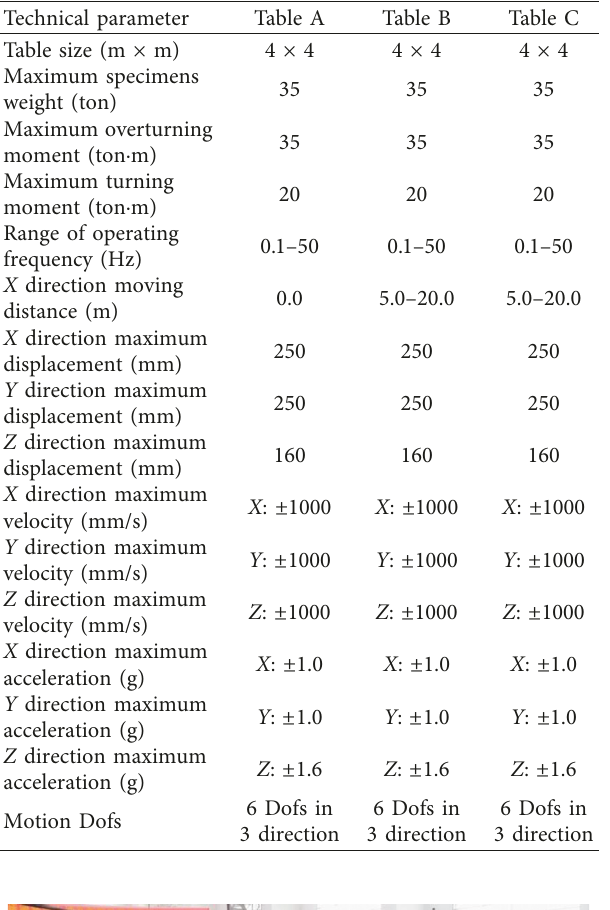
Table 2: Similarity ratios of the model to